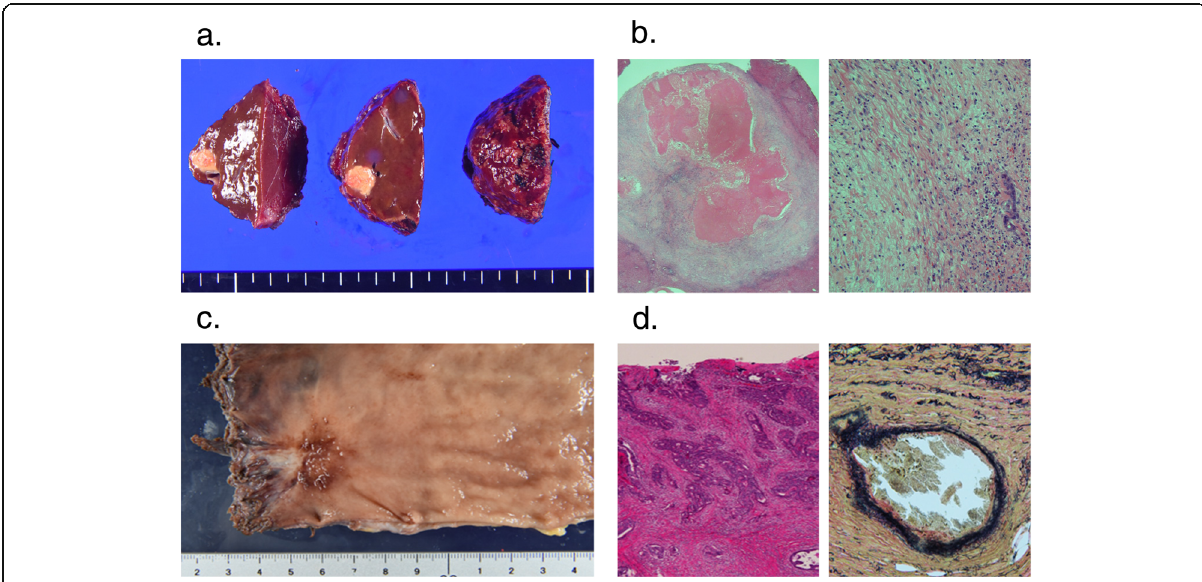
Fig. 4 Pathological findings of the specimen. a Macroscopic view of the liver metastases lesion (S4). b Distant and short-range view of hematoxylin and eosin staining of the liver metastases lesion. No viable carcinomic cells were identified. c Macroscopic view of CRC lesion. d Distant view of hematoxylin and eosin staining (left) and short-range view of Elastica van Gieson staining (right) of the CRC lesion. Glandular structure of intermediate-differential adenocarcinoma and viable carcinomic cells were packed within a small vein. CRC, colorectal